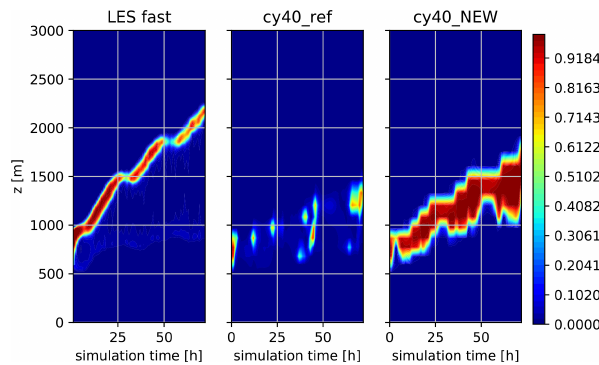
Figure 18. As Fig. 16 but for the fast